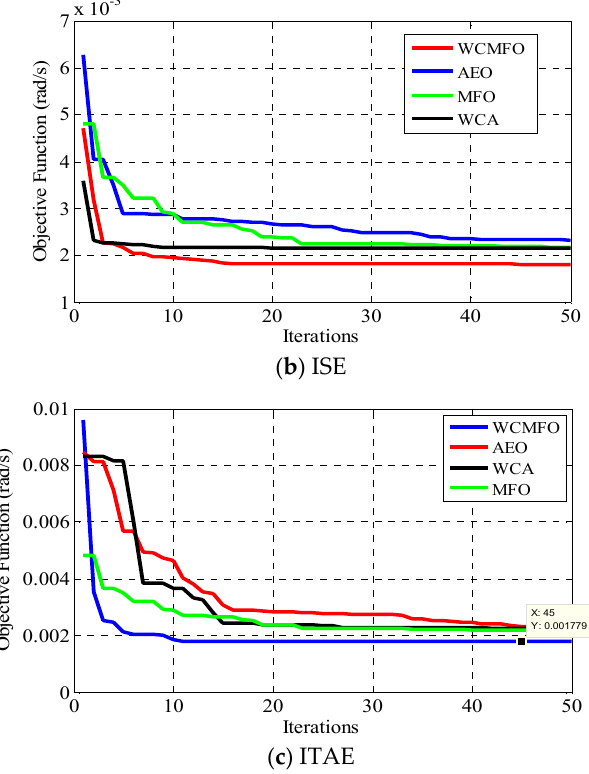
Figure 3. Convergence profile ( a ) IAE, ( b ) ISE, ( c ) ITAE using FOPID-PSS controller.